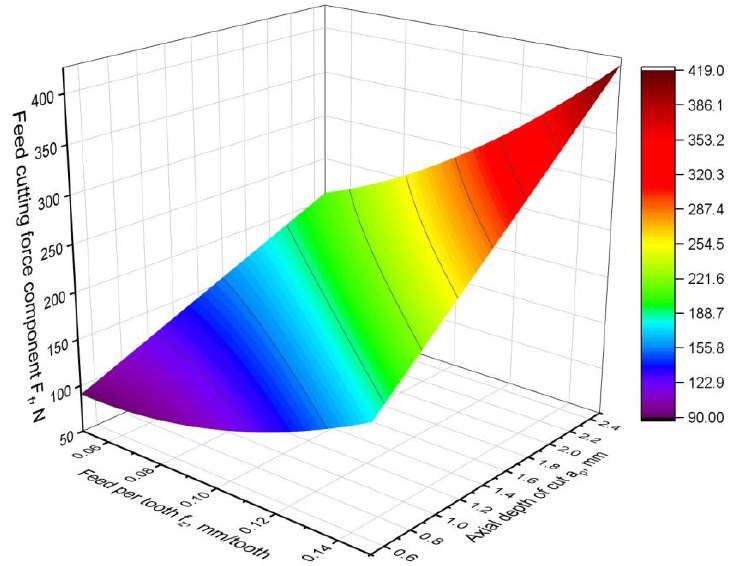
Figure 8. F eed cutting force component F f model. Figure 8. Feed cutting force component F f